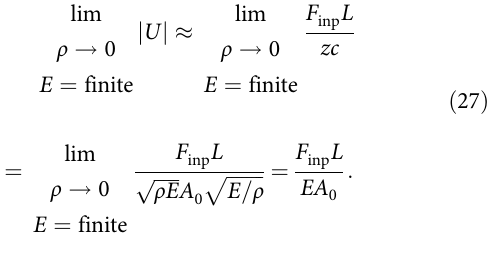
(cid:7) (cid:7) (cid:7) (cid:7) (cid:7) (cid:7) and z / z 0 as functions 0